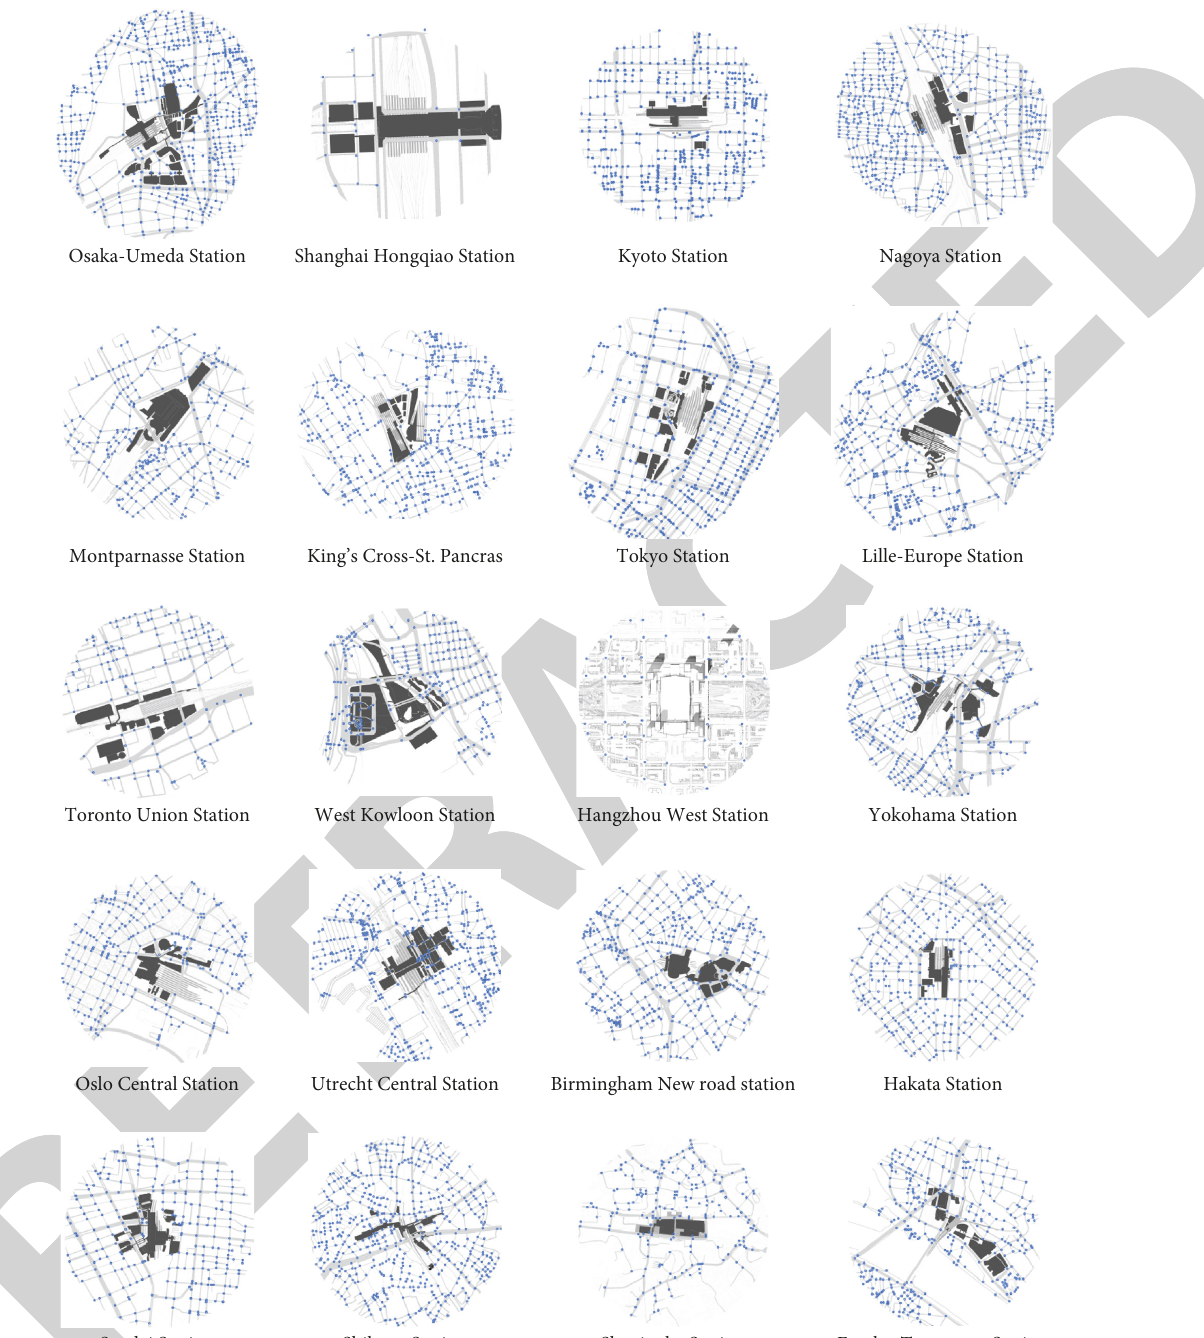
Figure 5: Intersection quantity